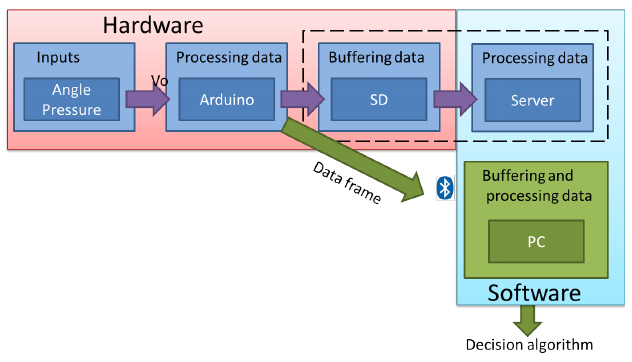
Figure 15. General scheme.